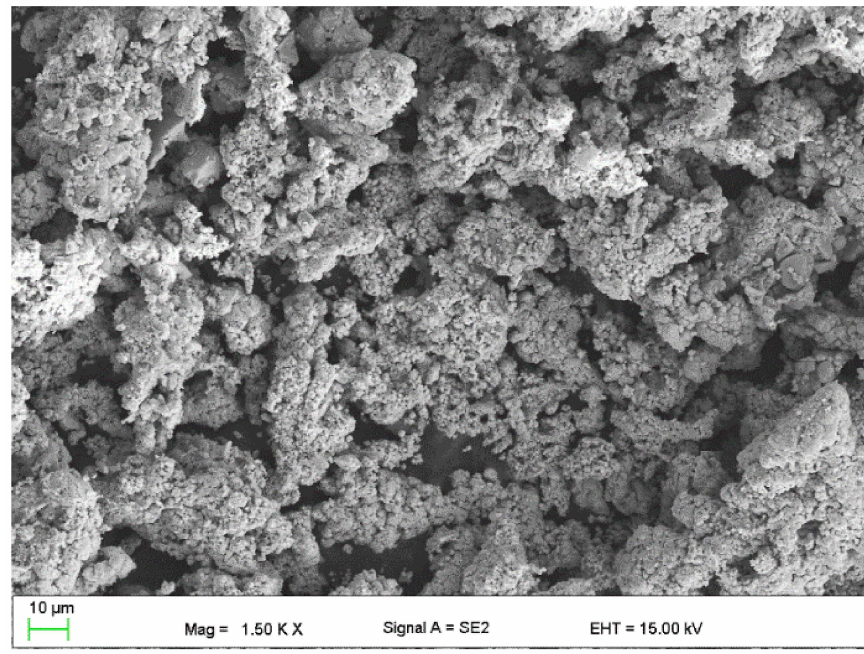
Figure 5. Copper powder after